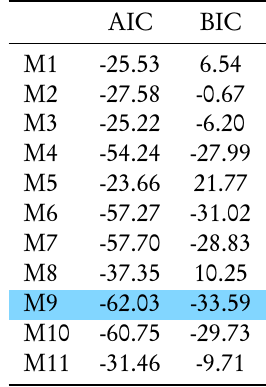
Information criteria for models M1 – M11 presented in Table 2. The corresponding parameter estimation are reported in Table 4 and Table